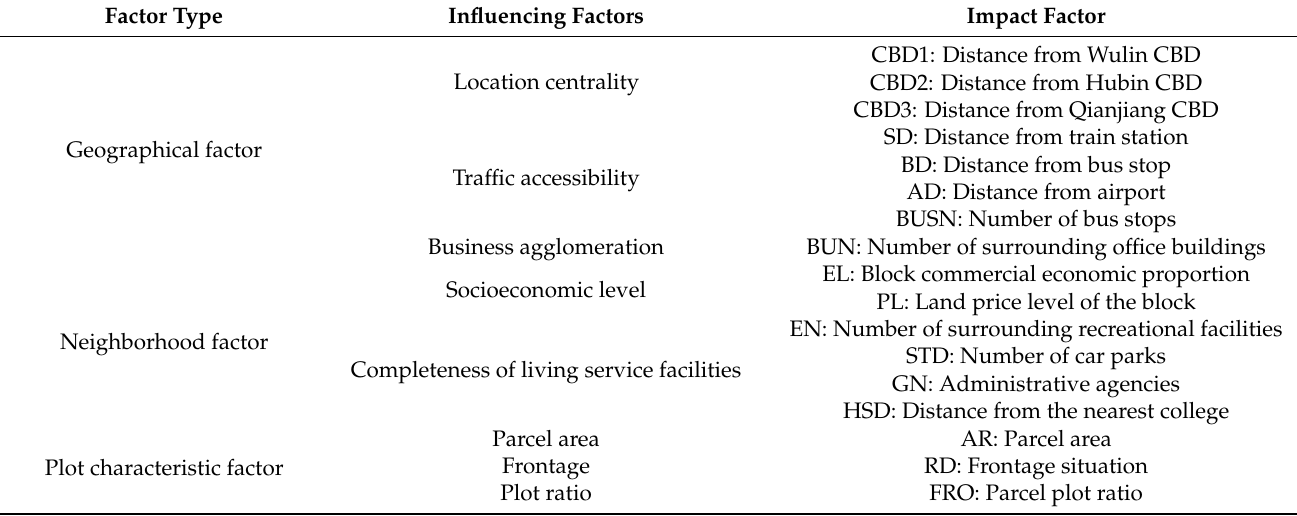
Table 1. Factors affecting the spatiotemporal evolution of commercial land prices in the main urban areas of Hangzhou. Factor